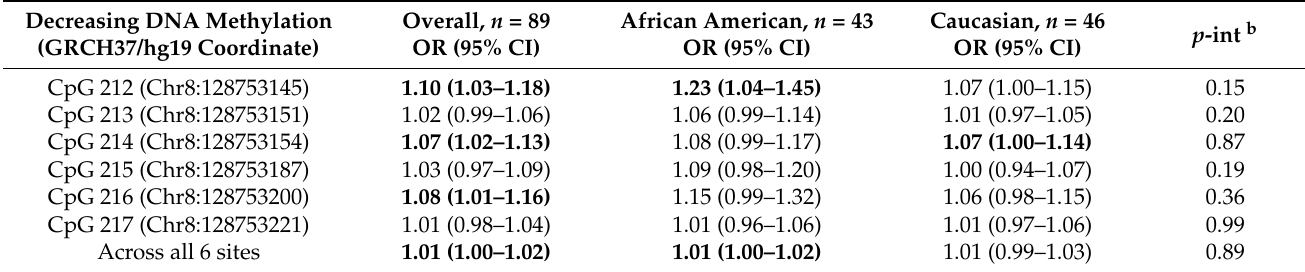
Table 3. Association between decreasing tumor MYC CpG site DNA methylation and tumor aggressiveness (GS 7 vs. 6), overall and by race in the University of Maryland samples a